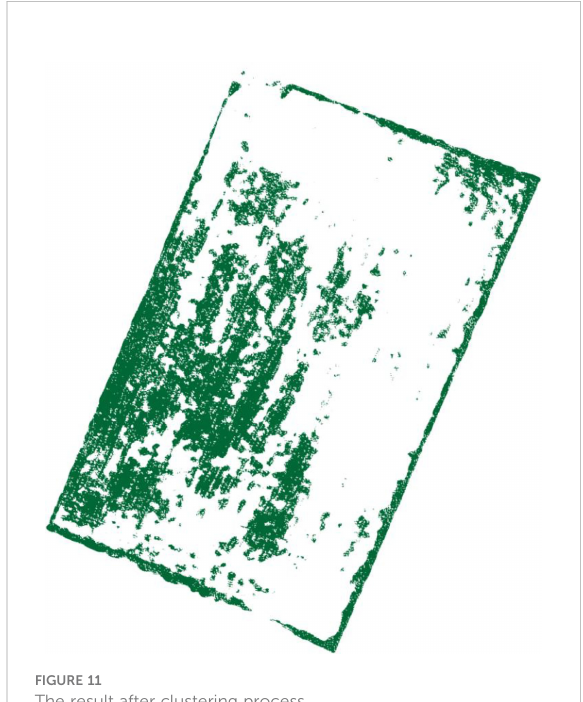
FIGURE 12 Before raster